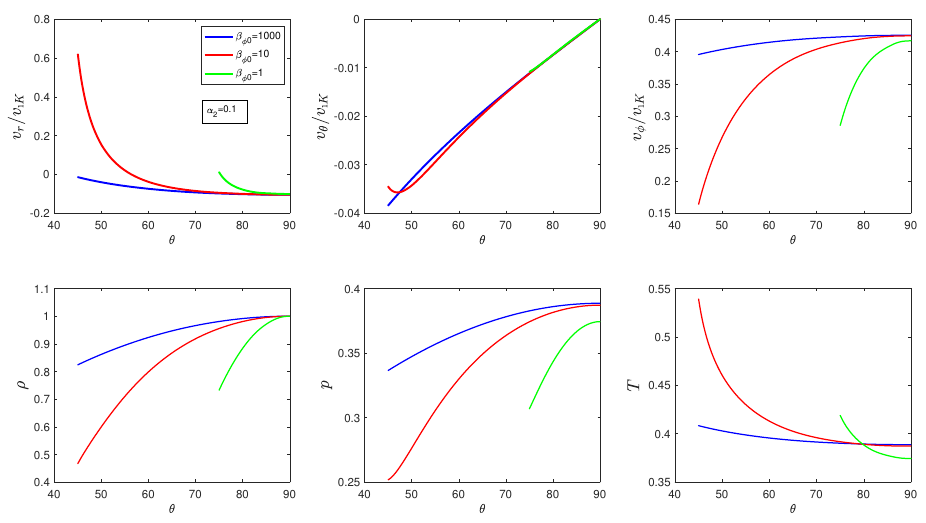
Figure 9. Angular profiles of a variety of physical variables. The blue, red, green lines correspond to parameters β φ 0 = 1000,10,1, respectively. Here, α 2 set to be